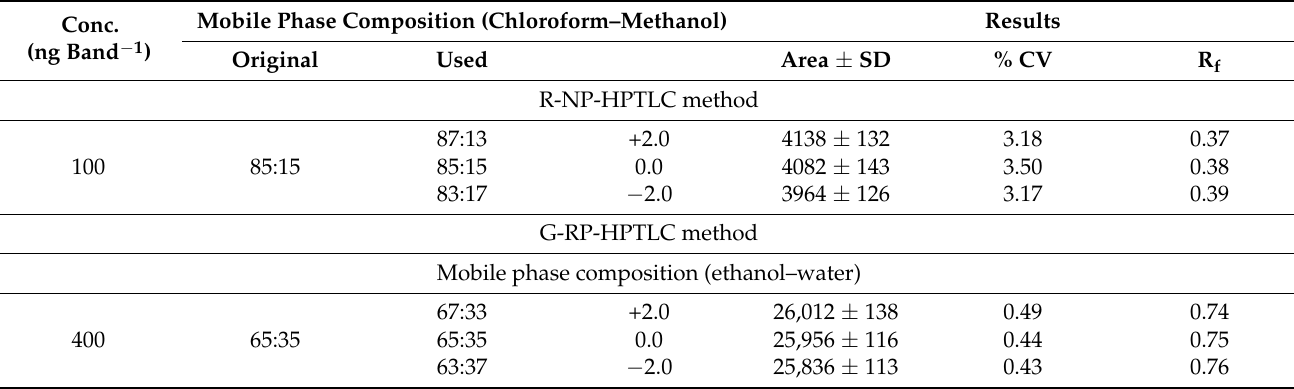
Table 5. Results of robustness evaluation for R-NP-HPTLC and G-RP-HPTLC methods (mean ± SD; n = 6).